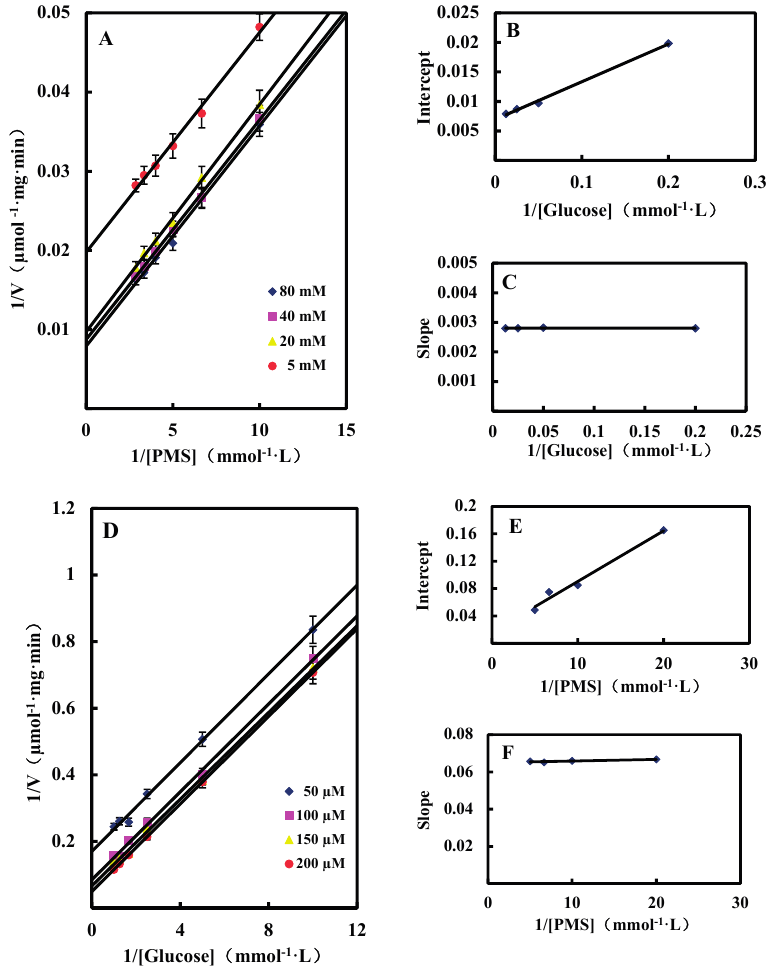
Figure 4. Initial velocity patterns for GlcDH reaction from A. globiformis C224. ( A )